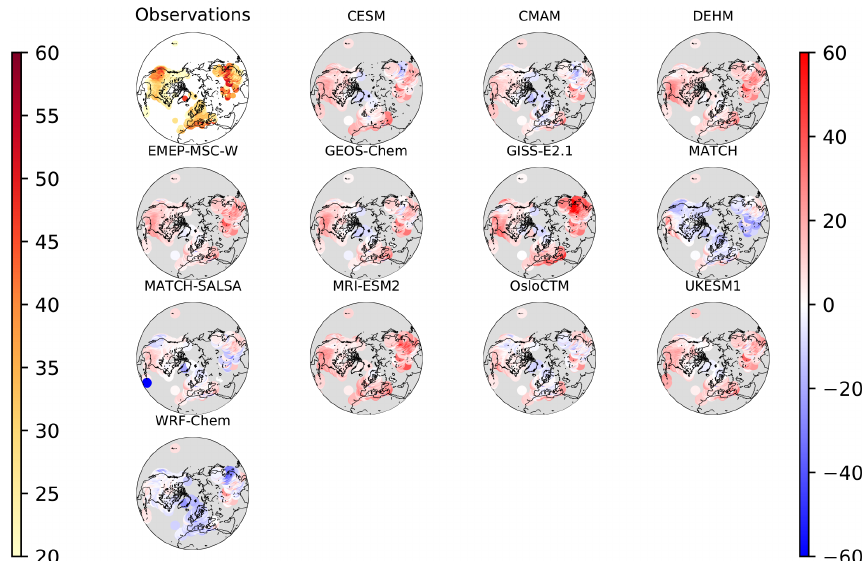
Figure 7. Summertime (JJA) (top left) mean in situ surface O 3 measurements (ppbv, left color bar) and (remaining panels) model biases for 2014–2015 (model minus measurement, also ppbv, right color bar). Results for 2008–2009 are similar but are not available for